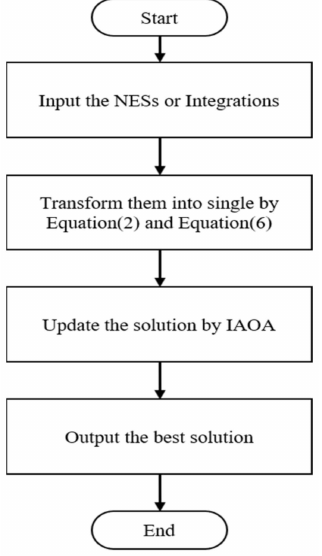
Figure 3. Flowchart for handling issues.